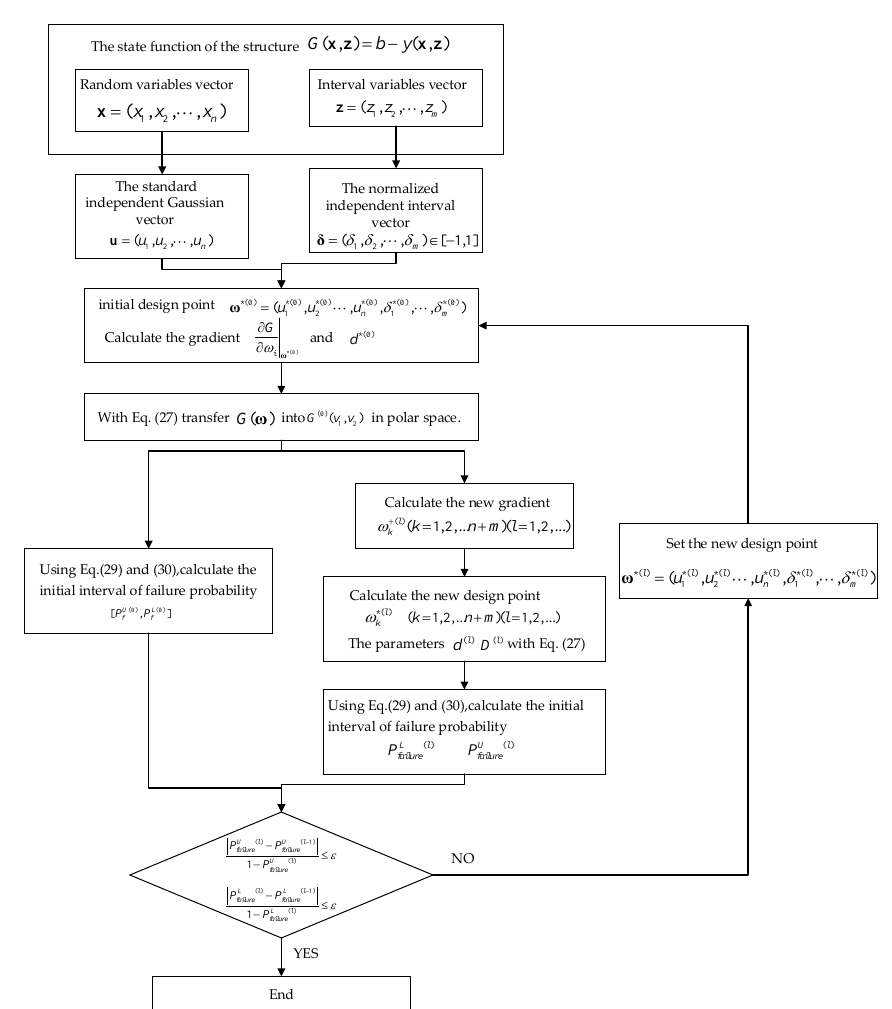
Figure 2. The flowchart of the implementation.